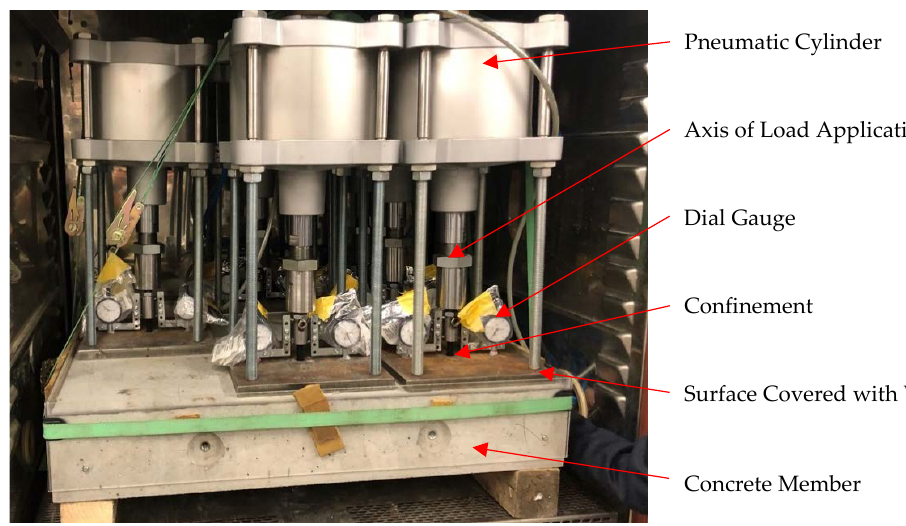
Figure 6. Used test setup in the climate chamber for the freeze-thaw condition tests. Table 1. Overview of the performed test programme under freeze-thaw conditions.